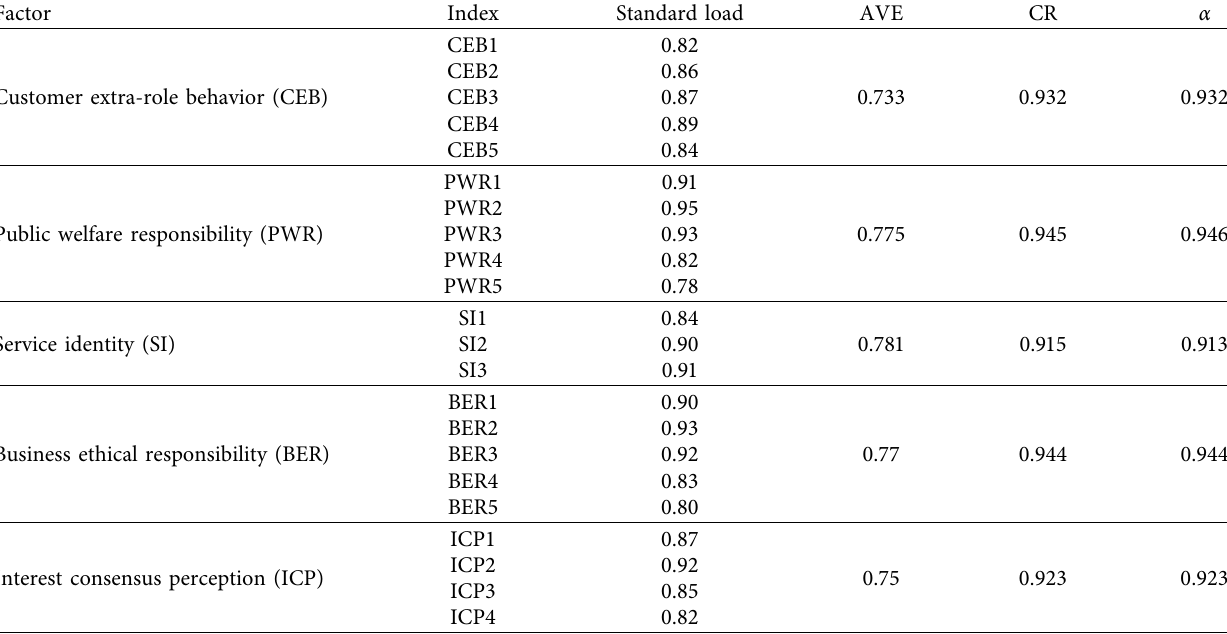
Table 5: Reliability and convergent validity analysis.